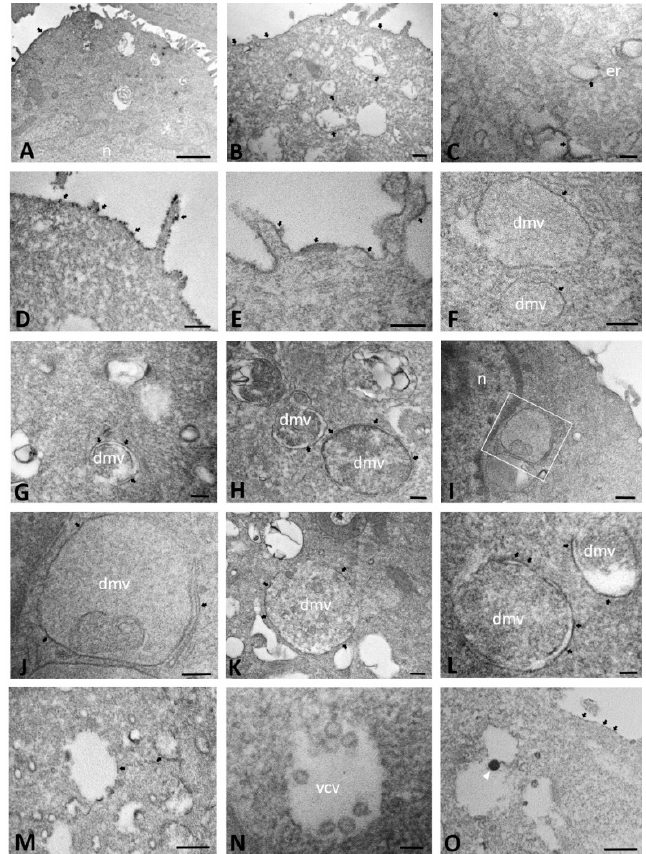
Figure 8. Immuno-electron microscopy showing ACE2 localization in mock-infected ( A ) and SARS-CoV-2-infected CFBE41o- ∆ F cells at 24 ( B – F ), 48 ( G – L ) and 72 ( M – O ) hours post infection. The boxed area in ( I ) is enlarged in ( J ). (dmv): double-membrane vesicles; (er): endoplasmic reticulum;